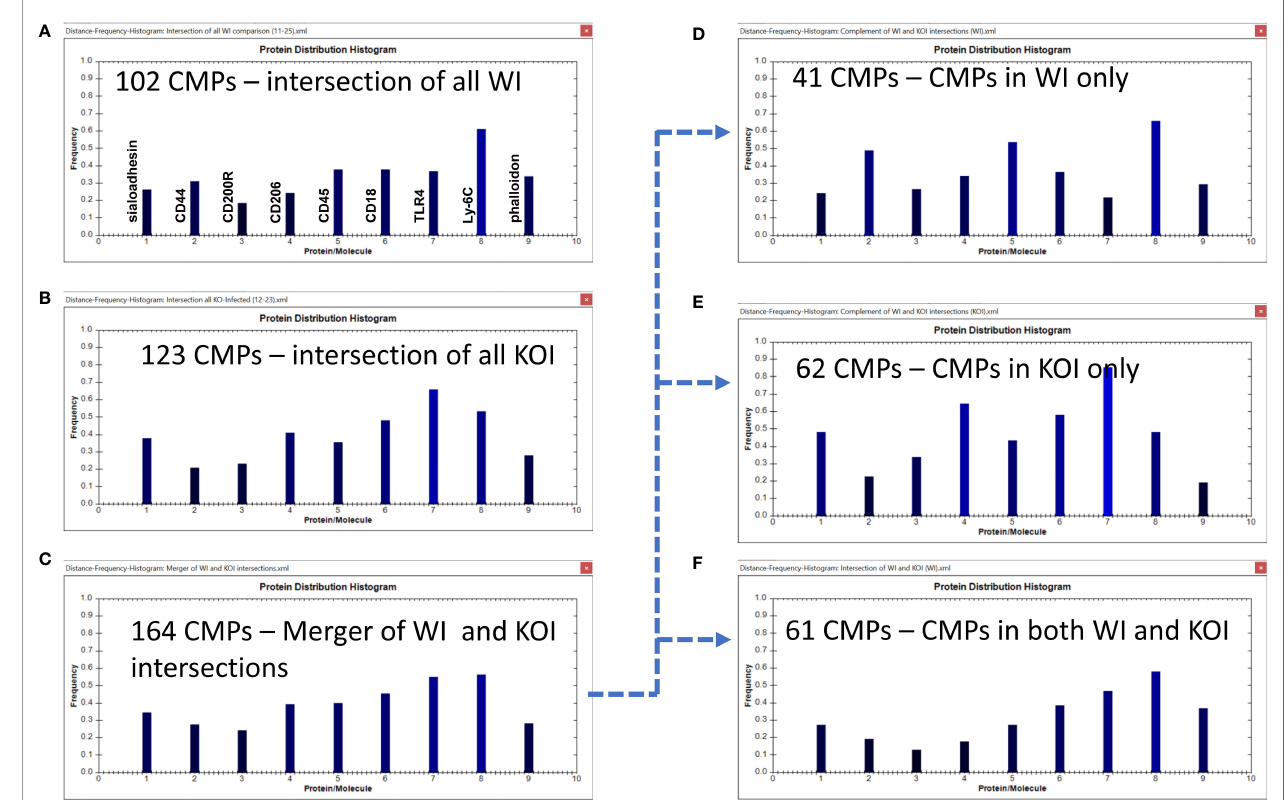
FIGURE 9 | CMP comparison of wild type infected (WI) and KO infected (KOI) AM. Panels (A, B) show the intersection of the three wild type infected and three KO infected samples. Panel (C) shows the results when the data in Panels (A, B) are merged and shows the characteristics of the 164 CMPs that are conserved in the WT and/or KO infected groups. Panels (D – F) use the complement feature of the TIS software to identify, from the 164 merged CMPs, CMPs present in wild type infected AM only (D) , KO infected AM only (E) , or common to both vehicle groups (F) . The arrow originating at Panel (C) and terminating at Panels (D – F) illustrates this